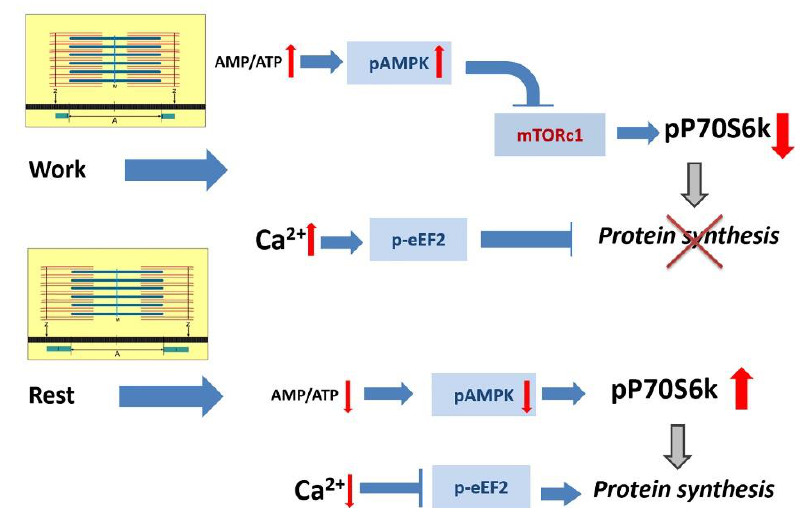
Figure 2. Suppression of the anabolic processes during muscle contractile activity and an upregulation of the anabolic processes after exercise. A contraction-induced increase in the concentration of AMP and calcium ions leads to the activation of AMP-activated protein kinase (AMPK) and eukaryotic elongation factor 2 (eEF2), respectively. AMPK suppresses the activity of mTORC1, and phosphorylated eEF2 (due to an increased calcium concentration) contributes to the inhibition of polypeptide chain elongation. After muscle contraction, AMPK activity decreases, and under reduced myoplasmic calcium concentration, dephosphorylated eEF2 stimulates polypeptide chain elongation enhancing the rate of muscle protein synthesis.